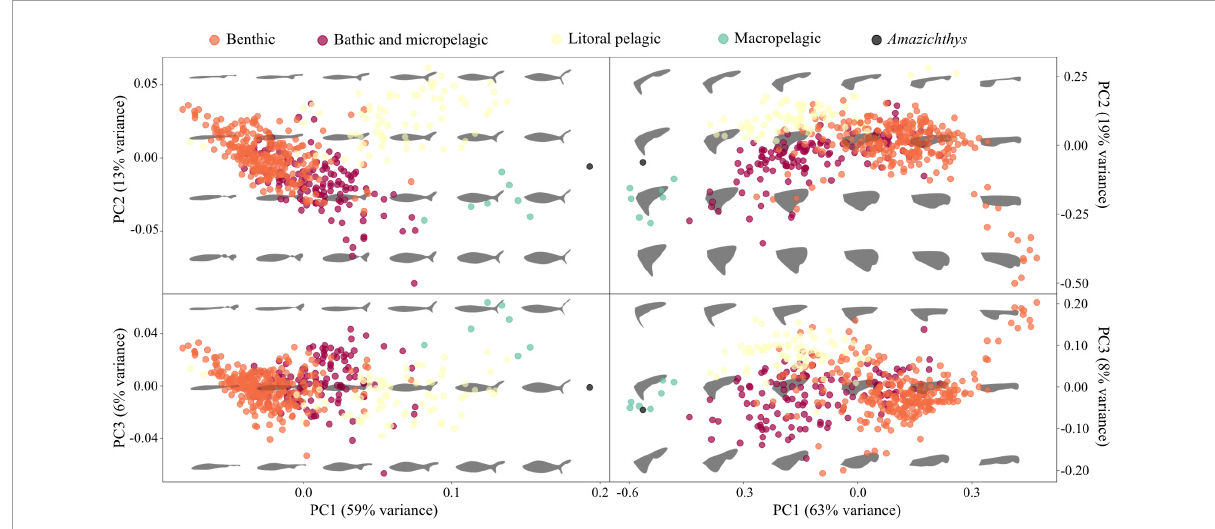
FIGURE11 Principal Component Analysis (PCA) results for the entire shark group and Amazichthys trinajsticae gen. et sp. nov. PCA plots for the first three PC axes show the distribution of ecological morphotypes based on Thomson and Simanek (1977) using the body outline and the caudal fin.